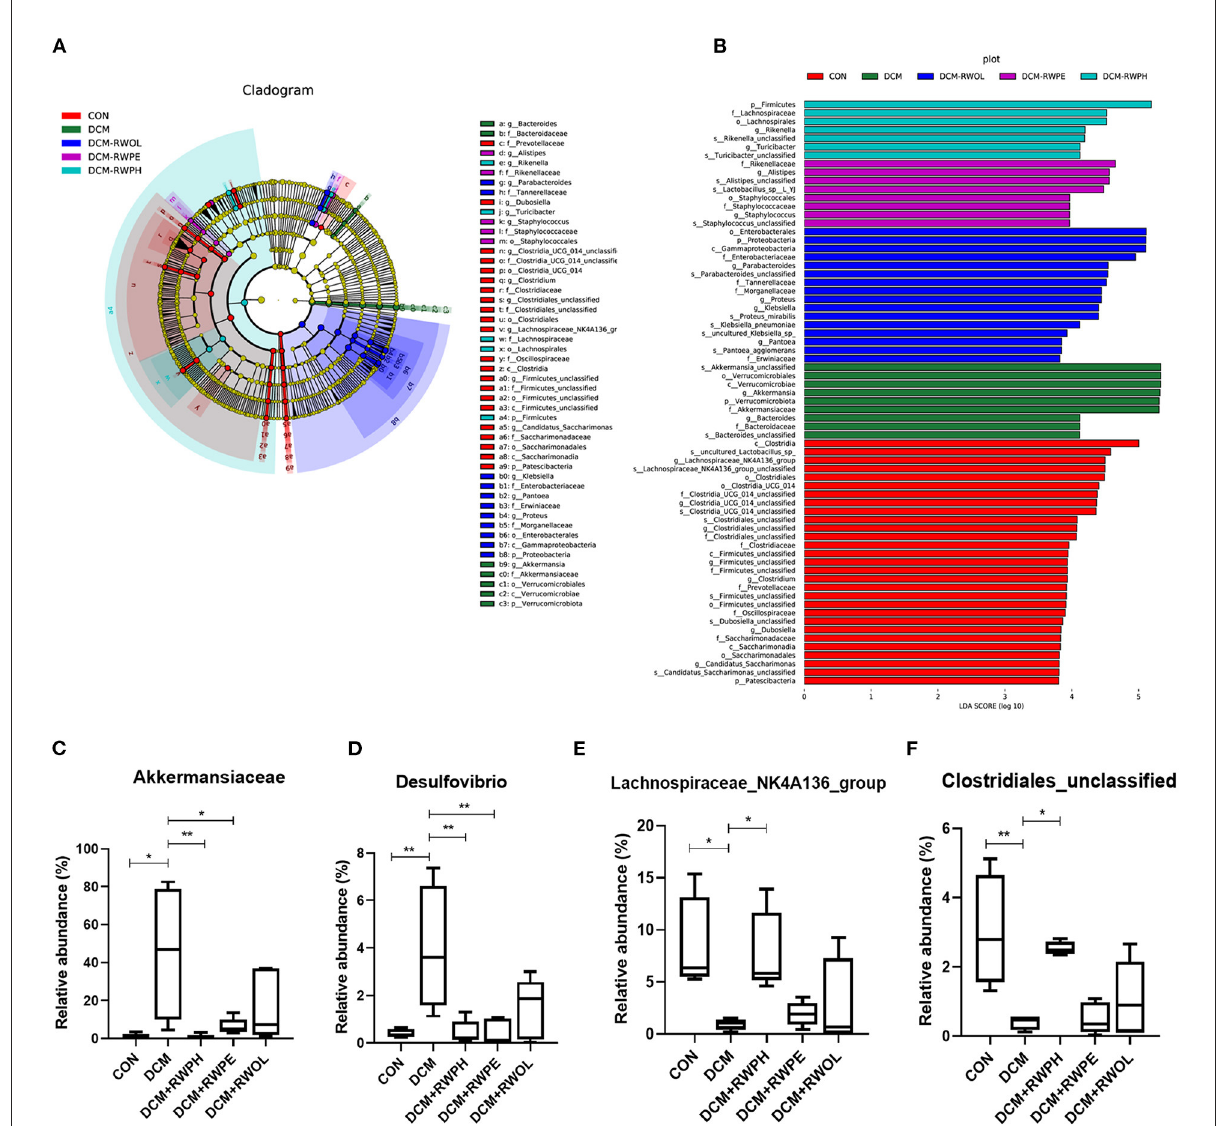
FIGURE7 Linear discriminant analysis effect size (LEfSe), linear discriminant analysis (LDA) and abundance comparison of representative gut bacterial taxa. (A) Comparison of taxonomic abundances using LEfSe. The circles represent the taxonomic levels from phyla to species. The dots, which size is proportional to its taxonomic abundance, located on individual circles represent different classification levels of bacteria. (B) linear discriminant analysis (LDA) represented significant difference in abundance of gut bacteria in the DCM/CON or DCM/DCM + treatment groups. (C–F) abundances of representative significantly changed gut taxa among groups. * P < 0.05; ** P <